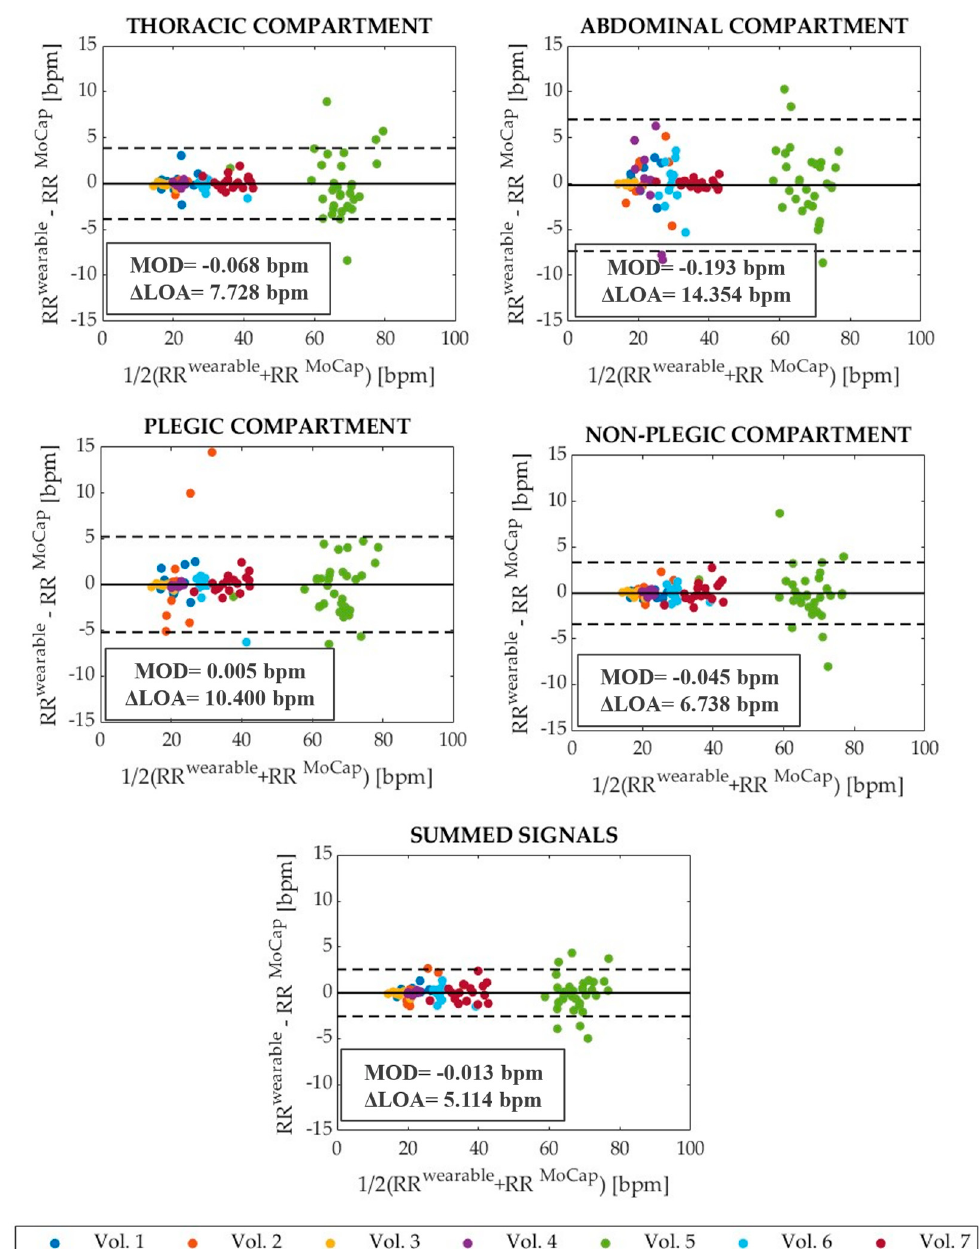
Figure 4. Bland–Altman plots showing the bias between RR wearable and RR MoCap calculated from the thoracic, abdominal, plegic, and non-plegic compartments’ data and the summed signals retrieved during the tachypnea trials (Trials 2). The MOD and Δ LOA are reported on each graph. In addition, MOD is represented with black solid lines, while Δ LOA is the span comprised between the two black dotted lines.